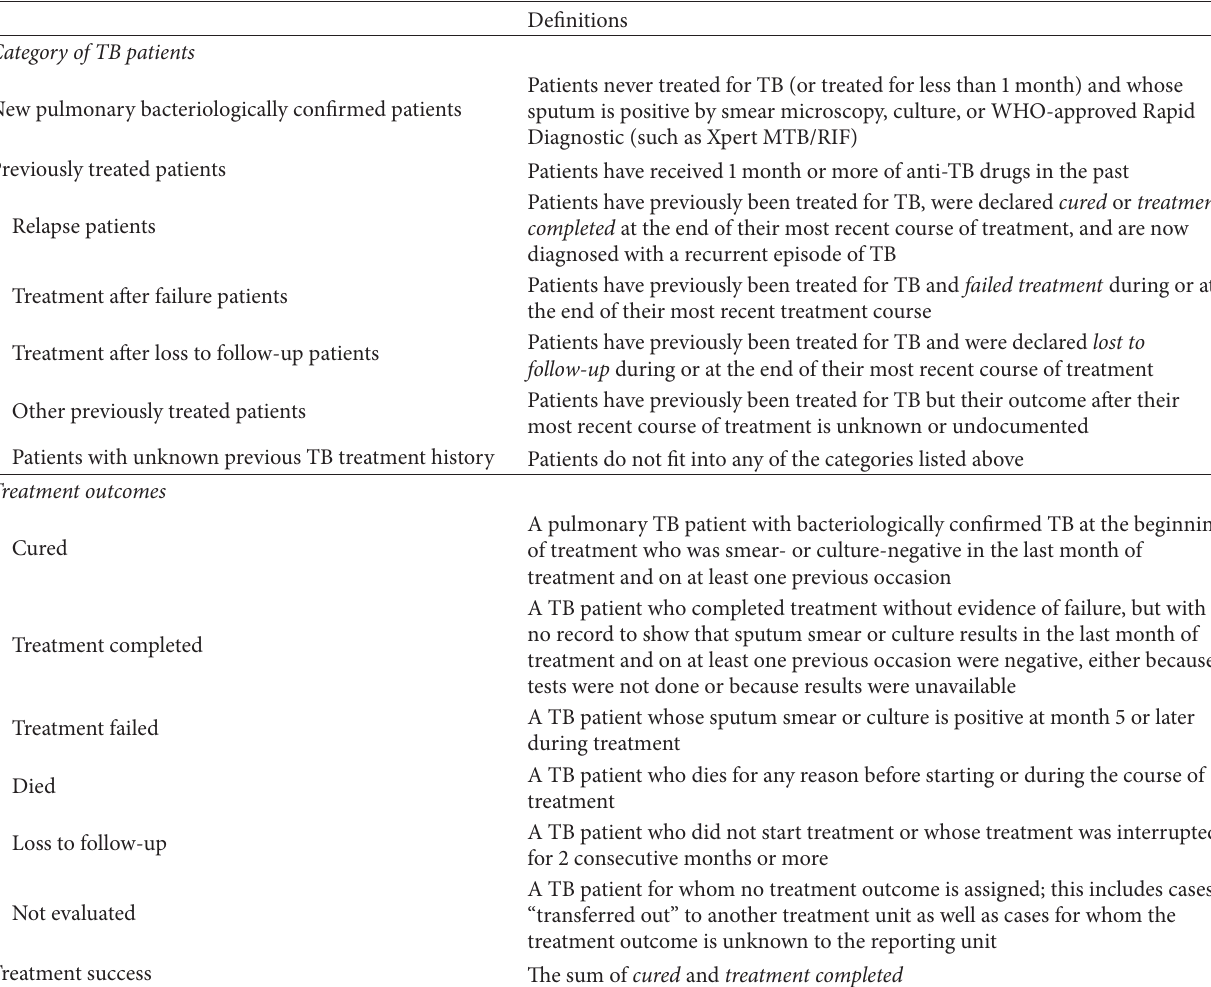
Table 1: New category of patients and treatment outcomes recommended by the WHO